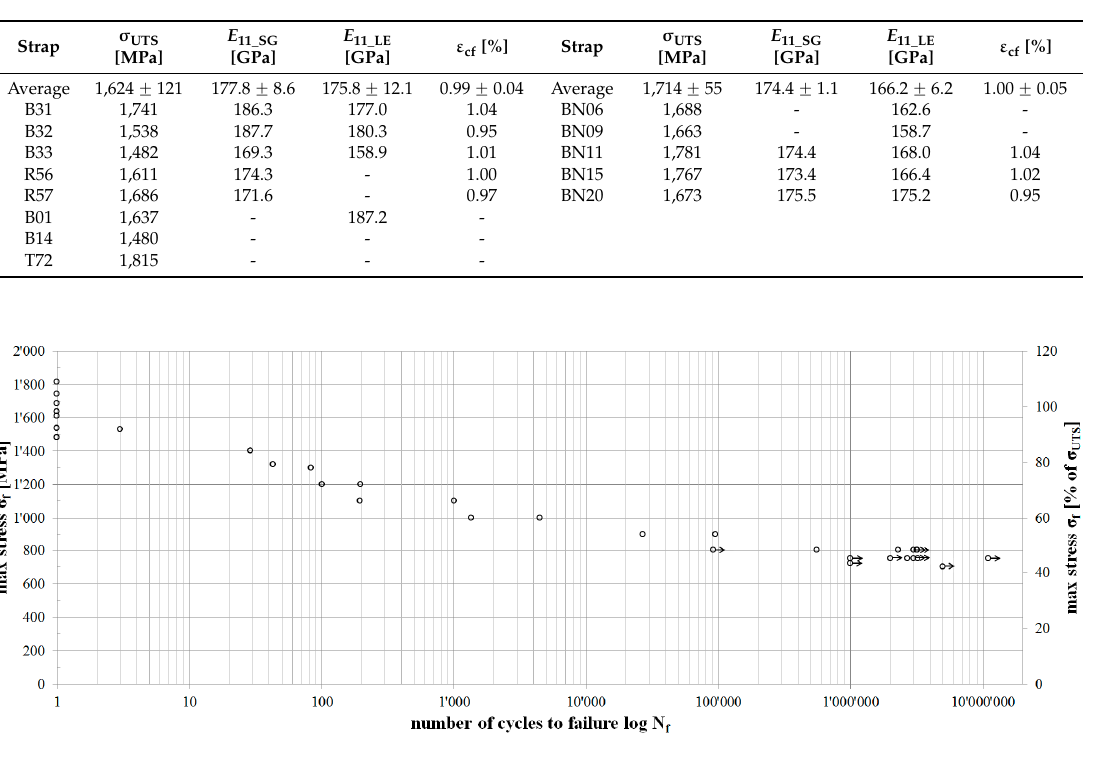
Figure 4. S–N curve of the 12 mm wide straps, listing the stress at failure ( σ f ) as a function of endured load cycles at failure ( N f ). Arrows are attached to data points of straps tested without failure, indicating that further load cycles could have been endured.